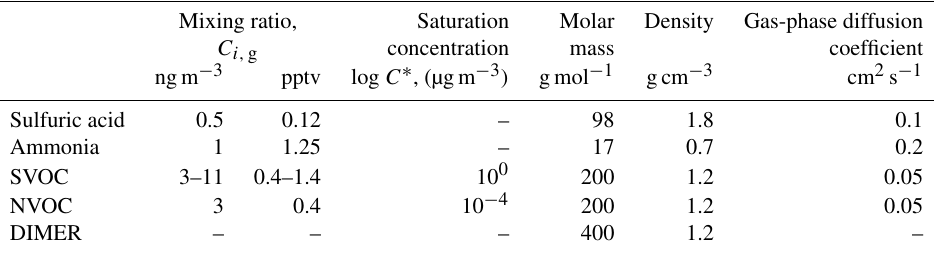
Table 1. Mixing ratios and relevant physical properties of chemical species included in particle growth calculations. T = 282 ◦ C, RH = 50%. Mixing ratio,